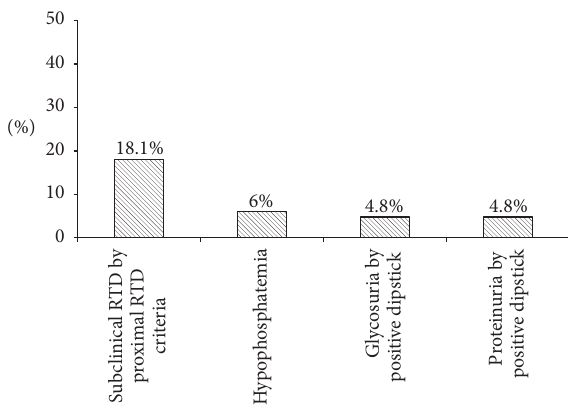
Figure 2: The percentage of subclinical renal tubular dysfunction defined by the proximal renal tubular dysfunction (RTD) criteria, hypophosphatemia, glycosuria, and proteinuria from positive uri- nary